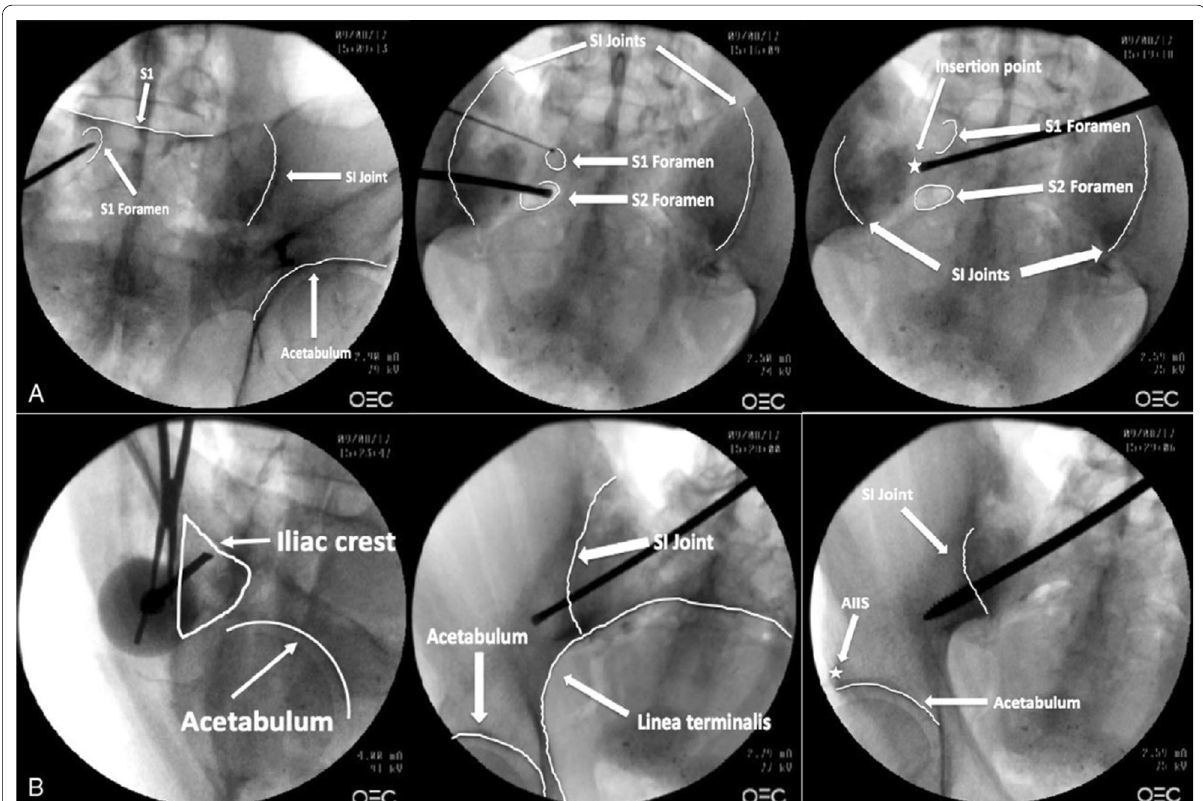
Fig. 18 The percutaneous S2AI screw insertion technique. A Entry point determination. Left: Localization of the S1 foramen using a standard probe. The white arrows refer to the S1 upper endplate, the SI joint, and the acetabulum. Middle: Localization of the S2 foramen. Right: The entry point (white star) is 10 mm lateral to the midpoint between S1 and S2 foramina. B Trajectory verification. Left: The probe is advanced keeping its tip in the center of the (teardrop) identified on the oblique obturator view. Middle: In the anteroposterior view, the probe is directed laterally in the transverse plane and caudally in the sagittal plane. Right: The screw is advanced in the direction of the AIIS (white star) (From Yilmaz E, Abdul-Jabbar A, Tawfik T, et al. S2 alar-iliac screw insertion: Technical note with pictorial guide. World Neurosurg 2018;113:296–301, Fig. 2, p. 297; Fig. 4, p. 298.)